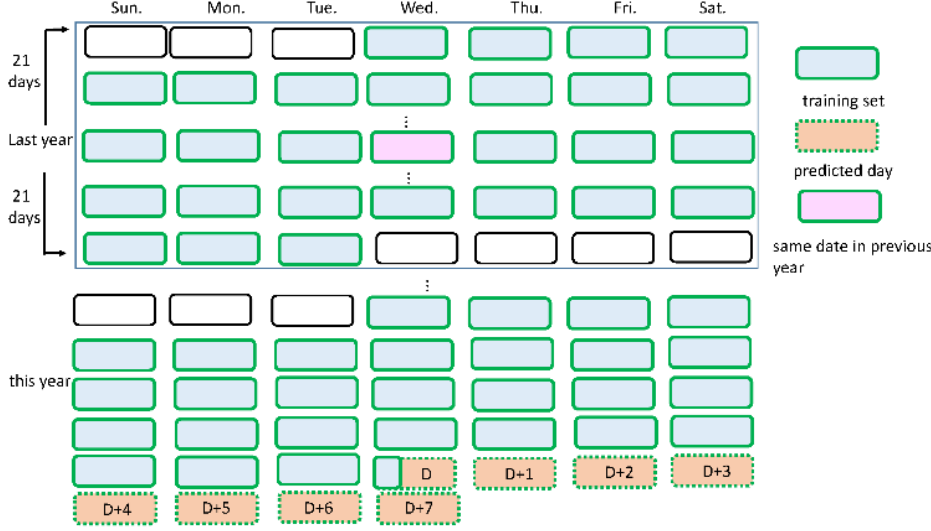
Figure 4. The training set used for model training. 3.2. Comparison of Test Results Obtained from the Semi-Parametric Model and the RNN Model The MAE, RMSE and MAPE of the accuracies of the load forecasts for every month from 2018–2019 are provided. The forecasting accuracies for the two models based on the historical temperatures serve as a baseline for comparison. In Table 2 the corresponding ( D + 1)-day monthly MAE, RMSE and MAPE of the two models with historical temper- atures are given in details. It can be seen that with the actual temperature, both models